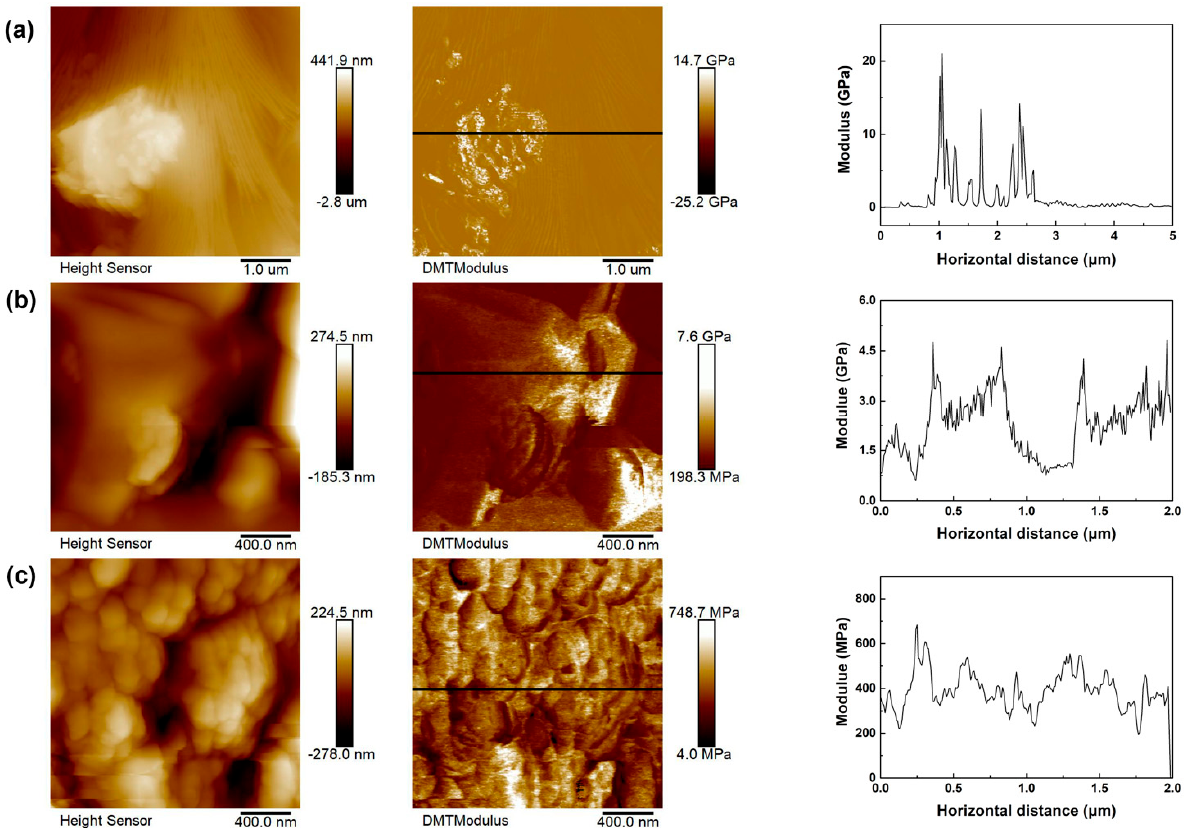
Figure 6. The height images, DMT modulus images with corresponding representative cross-sections and the surface DMT modulus values of ( a ) LAGP, ( b ) QSSCE and ( c ) PPG-co-PETA.